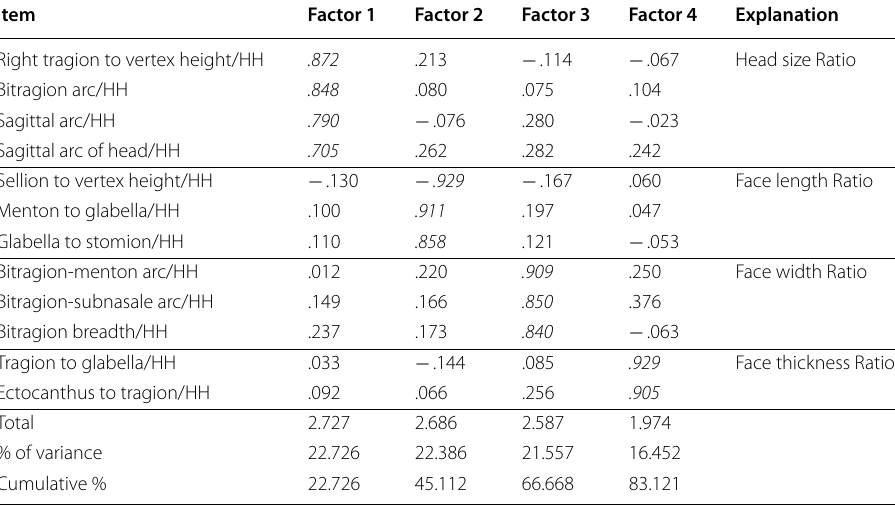
Italic values indicate high loading values HH head